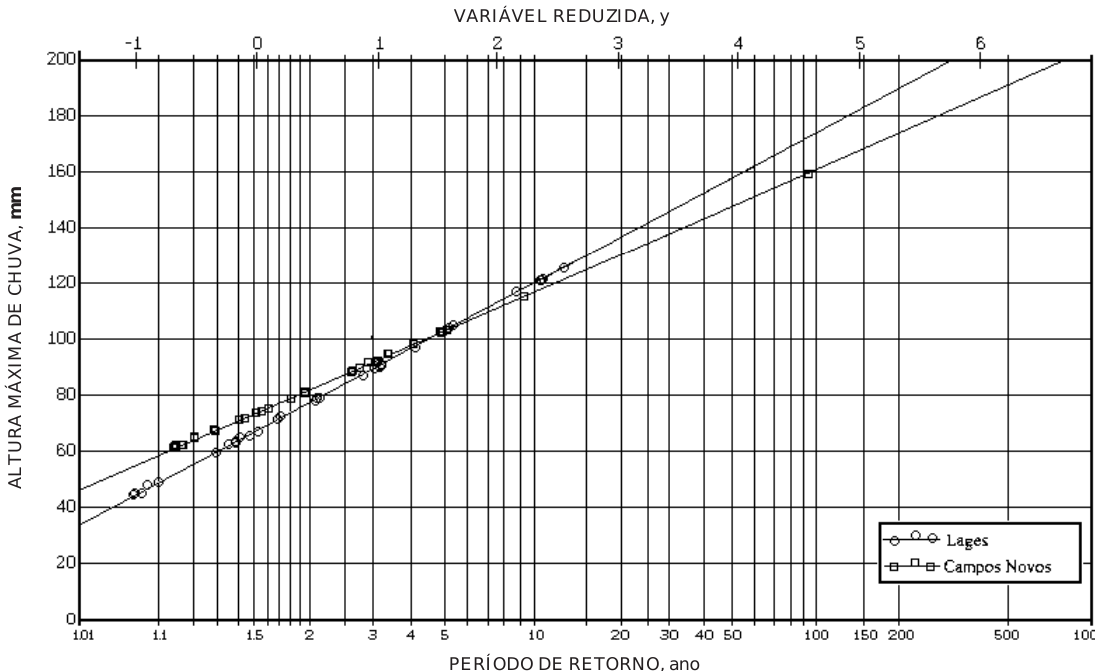
Figura 1. Ajuste gráfico da distribuição de Gumbel para Lages e Campos Novos (SC), no período de